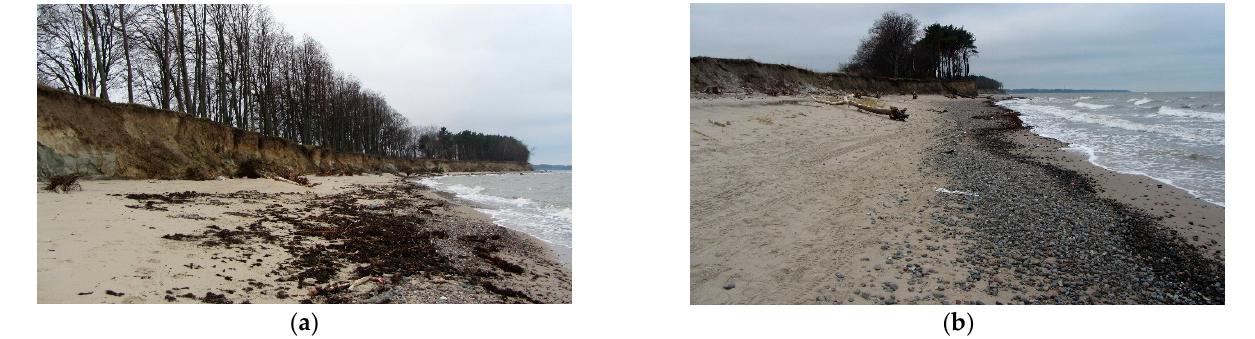
Figure 4. The photo of wash-out for case No.5: ( a ) Section 1. A narrow strip 1–1.5 m wide, about 100 m long; ( b ) Section 2. A narrow strip, turning into spots up to 6–8 m wide, about 400 m long.